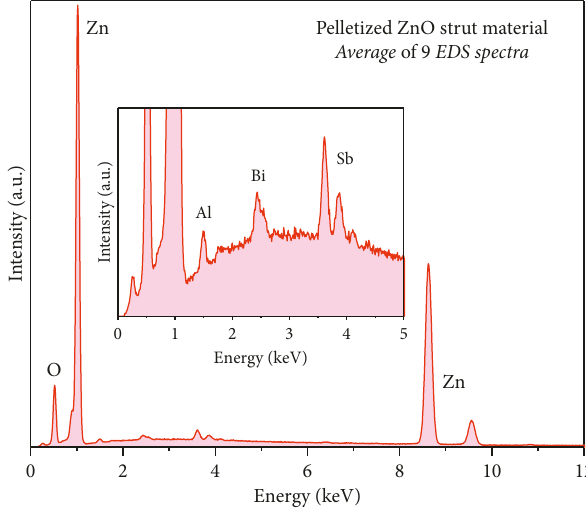
Figure 4: Approximation of the Al 3+ content in the cubic Zn 3 x Sb 2 − 1/3 x Al x O 12 secondary phase in the ZnO strut material by applying Vegard’s law on published crystallographic data of the pure spinels α -Zn 7 Sb 2 O 12 and ZnAl 2 O 4 ( � Zn 3 Al 6 O 12 ) as well as an Al-doped spinel with the composition Zn 3 Sb 1.5 Al 1.5 O 12